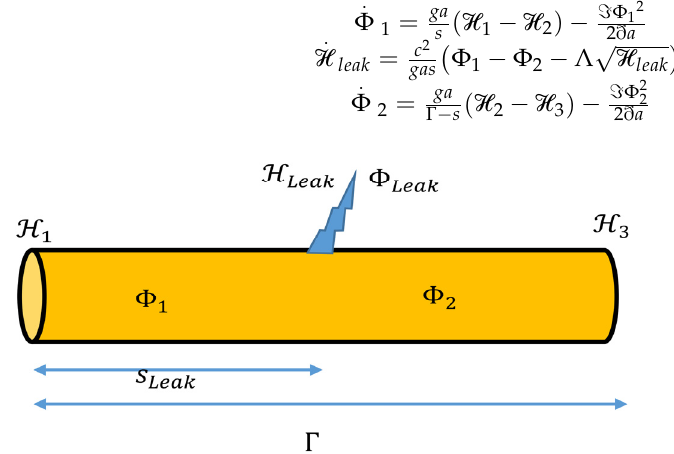
Figure 2. The suggested pipeline